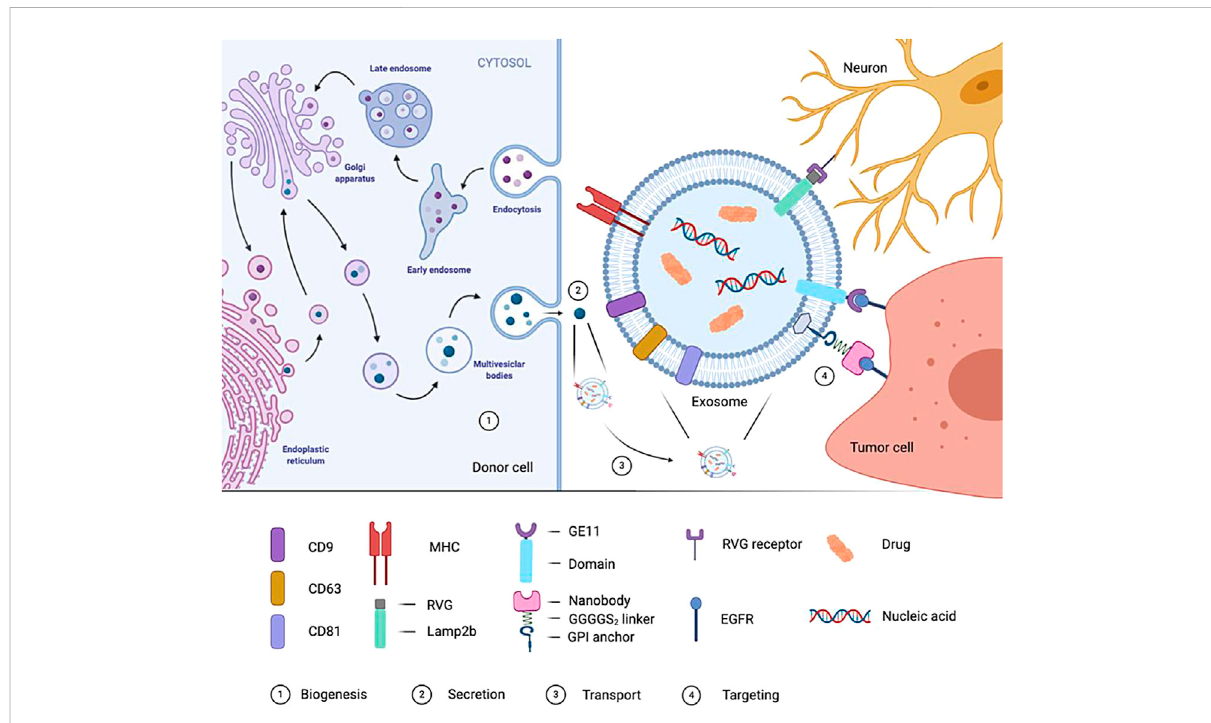
FIGURE 5 Formation of exosome and targeted process. In the genetically-modi fi ed donor cells, the biogenesis process of cell-derived exosomes is showed. Mature exosomes are released by the donor cells, transported by body fl uids to reach the target cells, and interact with the target cells through speci fi c targeting molecule.